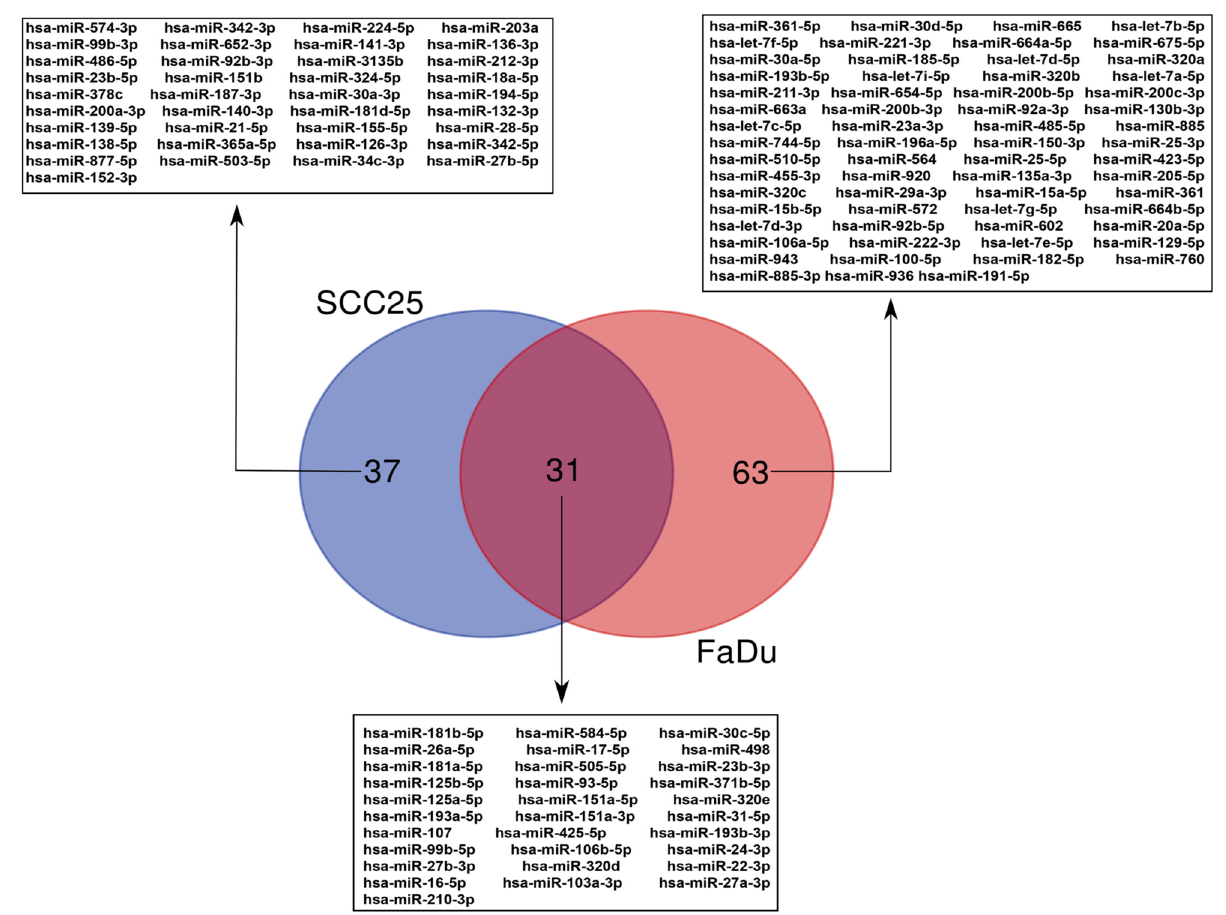
Figure 2. Venn diagram showing miRNAs detected in EVs isolated from FaDu and SCC25 cell culture medium using microarray assays.